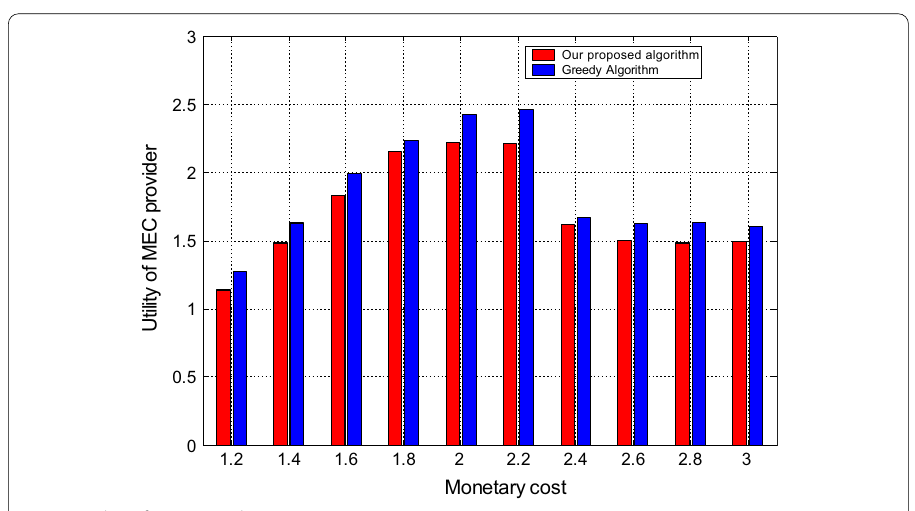
Fig. 2 Utility of MEC provider versus monetary